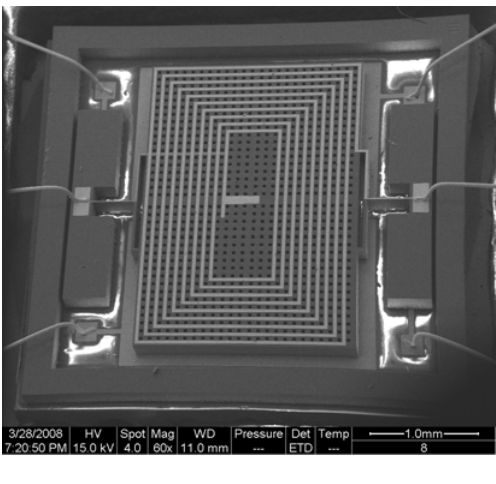
Figure 4. SEM photo of the fabricated MEMS torsional resonant magnetometer.